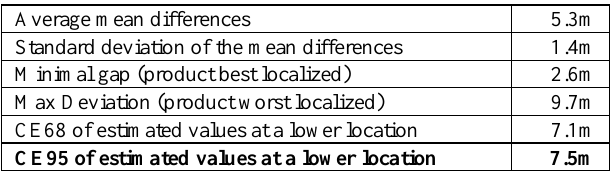
Table 5. Geolocation performances statistics on the South America GRI.